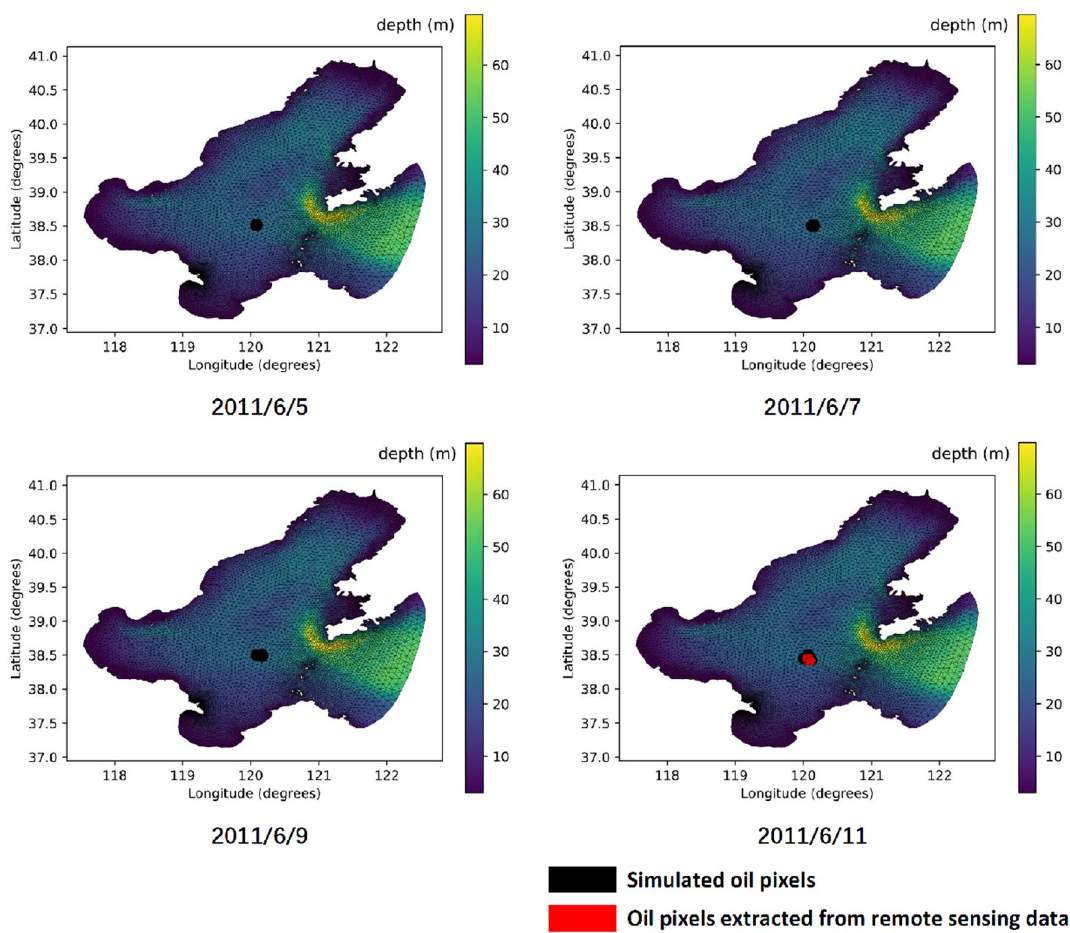
Figure 7. Simulation results of the proposed COSSD method.